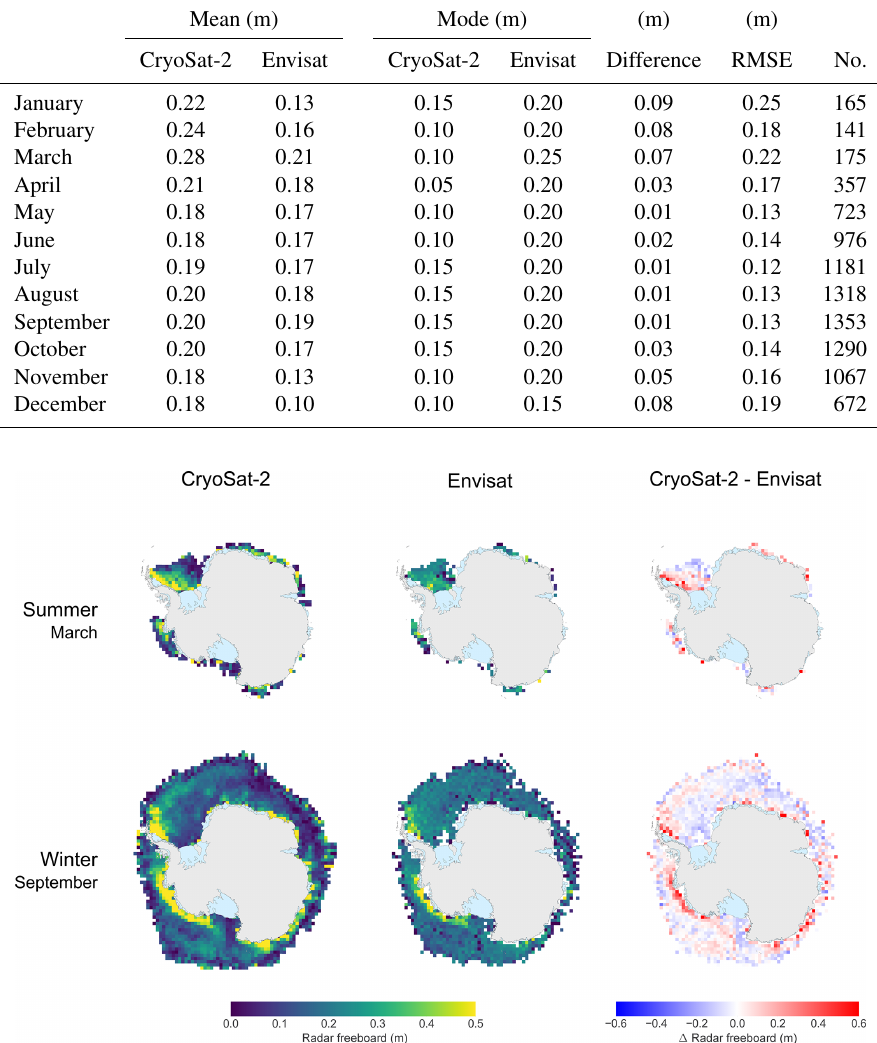
Figure 2. Freeboard maps derived from CS-2 (left panels) and Envisat (center panels), and the difference between both products (right panels) shown for sea-ice minimum in summer (top panels) and maximum in winter (bottom panels). Light blue areas represent the Antarctic ice